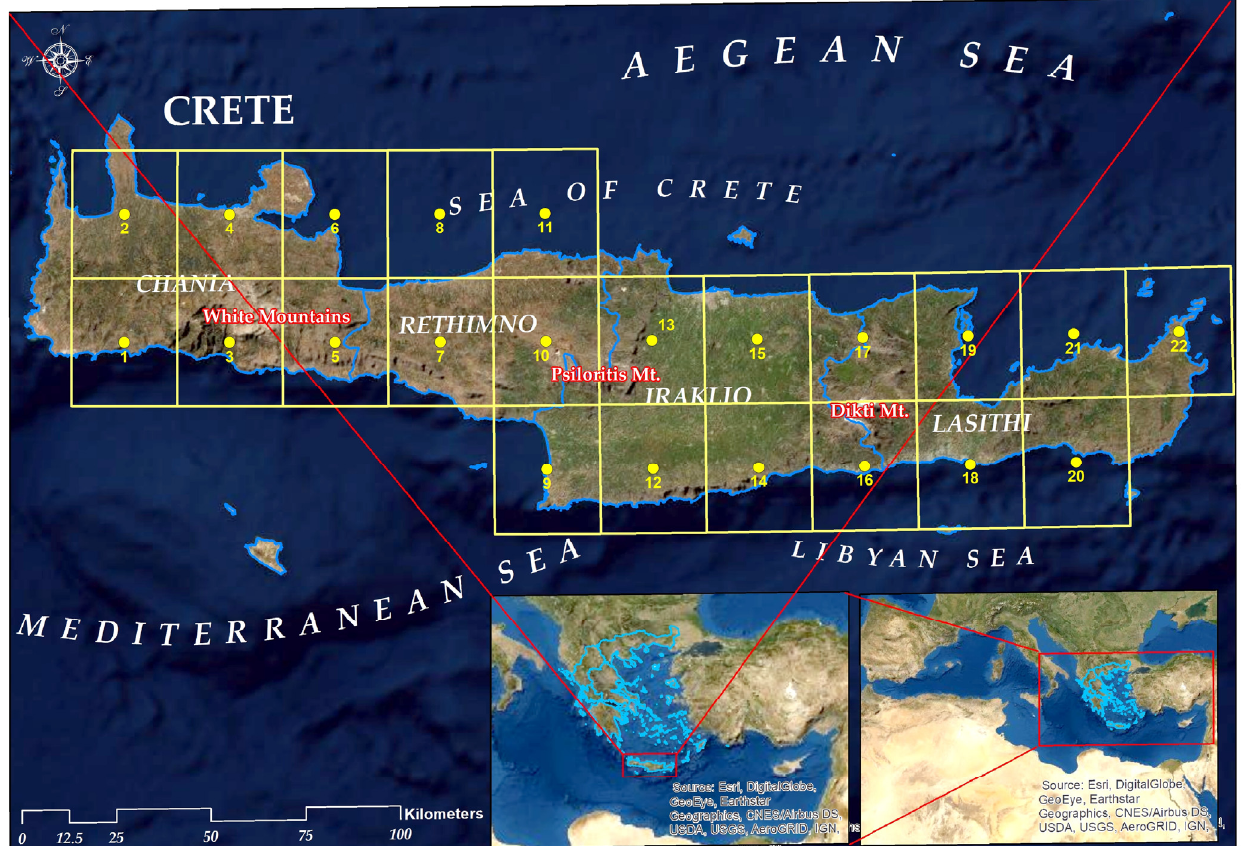
Figure 1. Crete, Greece. The study area and the polygons (1–20) used for downscaling (Hellenic Geodetic Reference System 1987—HGRS87).